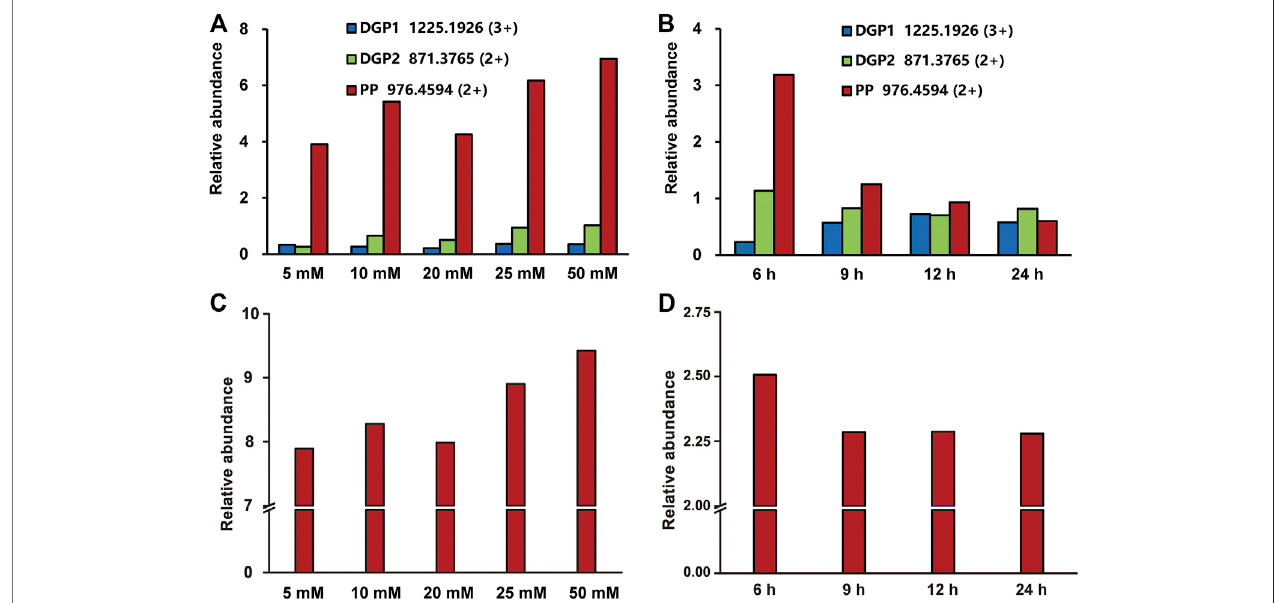
FIGURE 2 | Optimization of the on-line deglycosylation conditions in different NH 4 OAc concentrations (A, C) and deglycosylation times (B, D) . The relative abundances of the target deglycosylated peptide and the phosphopeptide obtained after the online deglycosylation (A) in different concentrations of NH 4 OAc or (B) for differentdeglycosylationtimes.Therelativeabundancesofthe s tandardphosphopeptide (C) indifferentconcentrationsofNH 4 OAcor (D) in50 mMNH 4 OAcfordifferent times. DGP, deglycosylated glycopeptide; PP,